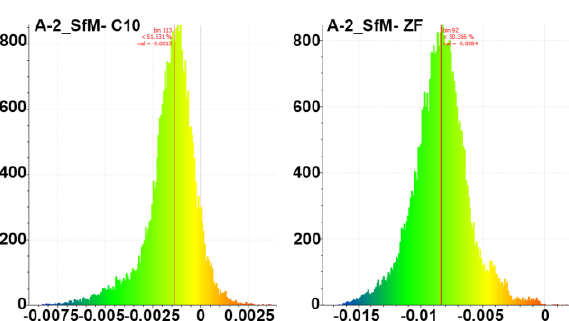
Figure 10 . A-2. Histograms of the comparison between SfM and C10 (left) and SfM and ZF (right).